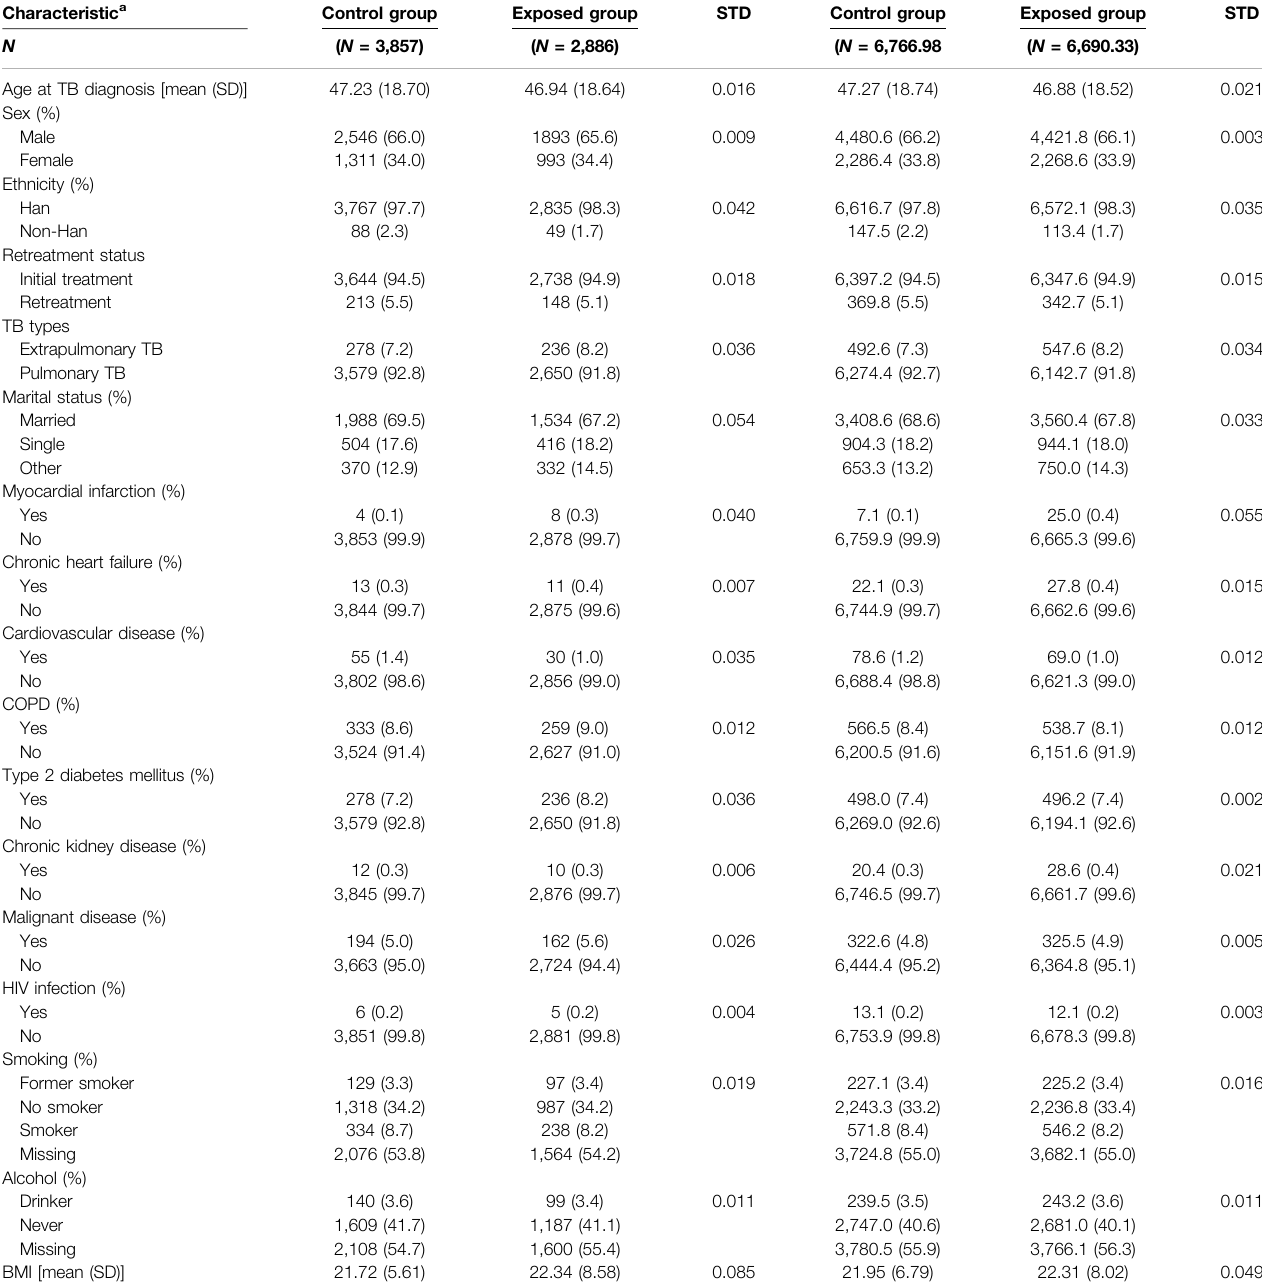
TABLE 1 | Demographic and clinical characteristics of the cohort before and after high-dimensional propensity score weighting. Characteristic